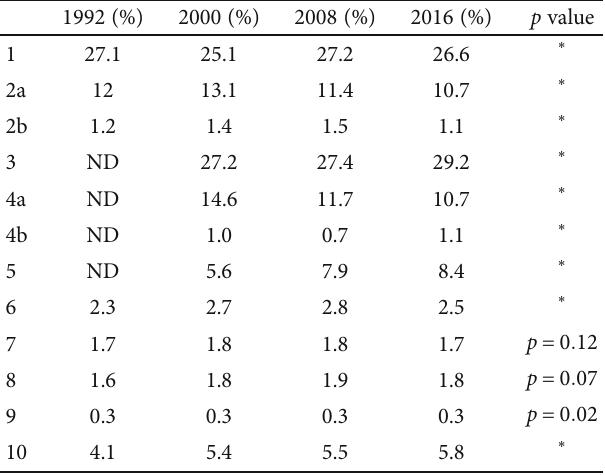
Table 2: Patient, pregnancy, and delivery characteristics. Table 3: Robson ’ s 10-Group Classi fi cation of Flemish women giving birth in 1992-2000-2008-2016: relative size of each group in total birth